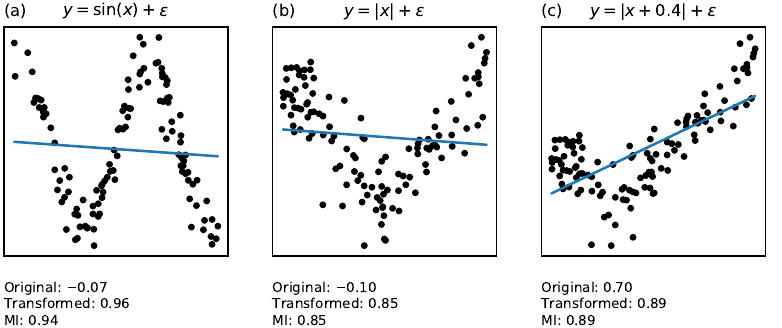
Figure 1. Examples of best linear fit lines (blue solid lines) to three different types of non-linear relationships, the Pearson correlation coefficient before and after transforming the x variable, and the MI correlation. Each sample has 120 points ( a – c